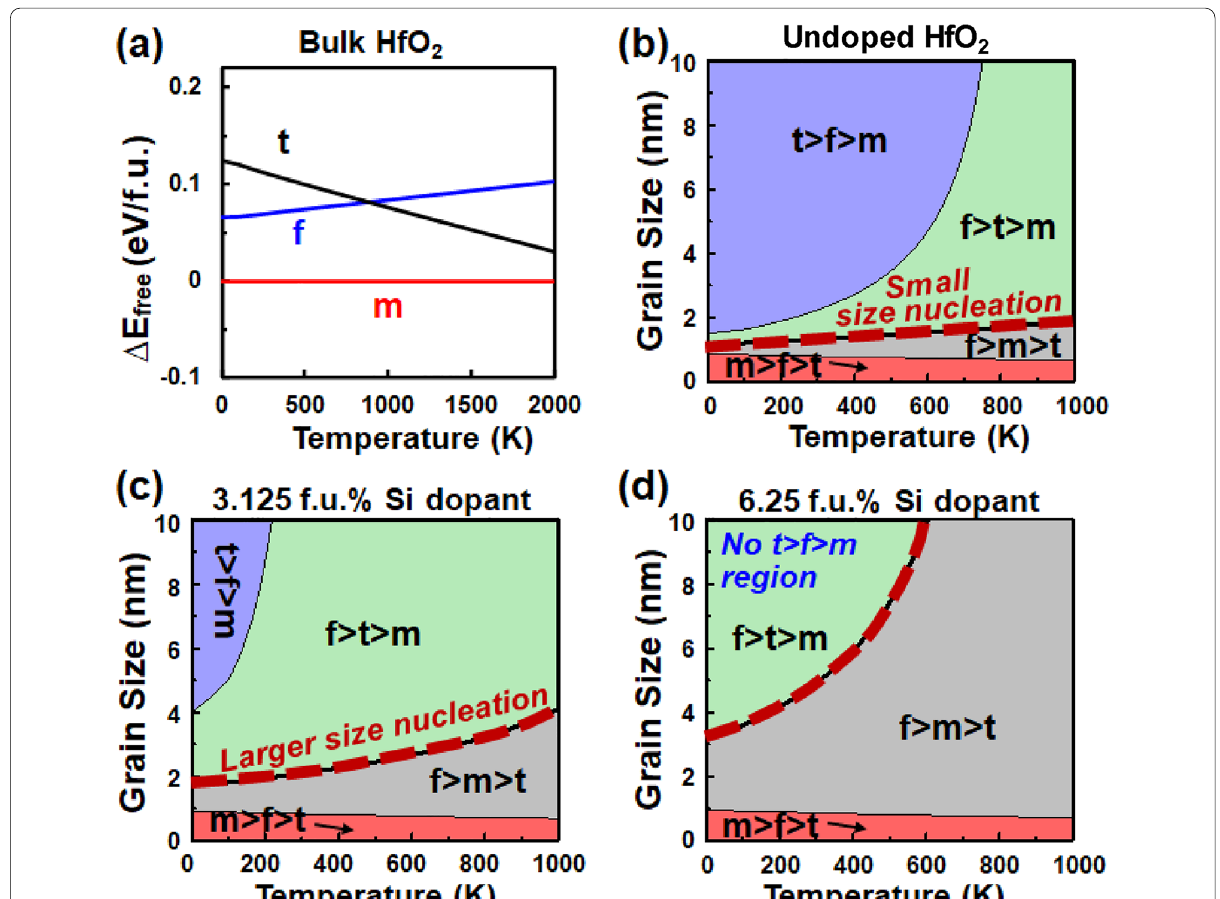
Fig. 2 ( a ) Calculated free energy of bulk HfO 2 at finite temperature with reference to the m-phase. Phase order diagrams based on free energies of m, t, f-phases of ( b ) undoped HfO 2 , ( c ) 3.125 f.u. % Si doped HfO 2 , and ( d ) 6.25 f.u. % Si doped HfO